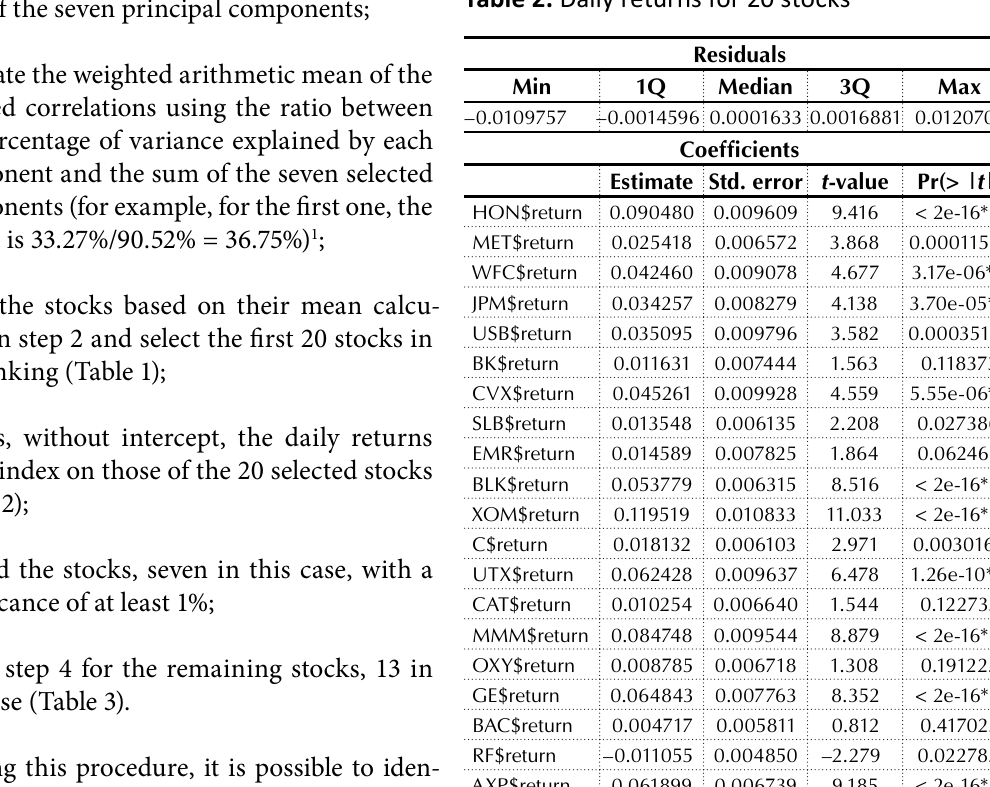
Table 2. Daily returns for 20